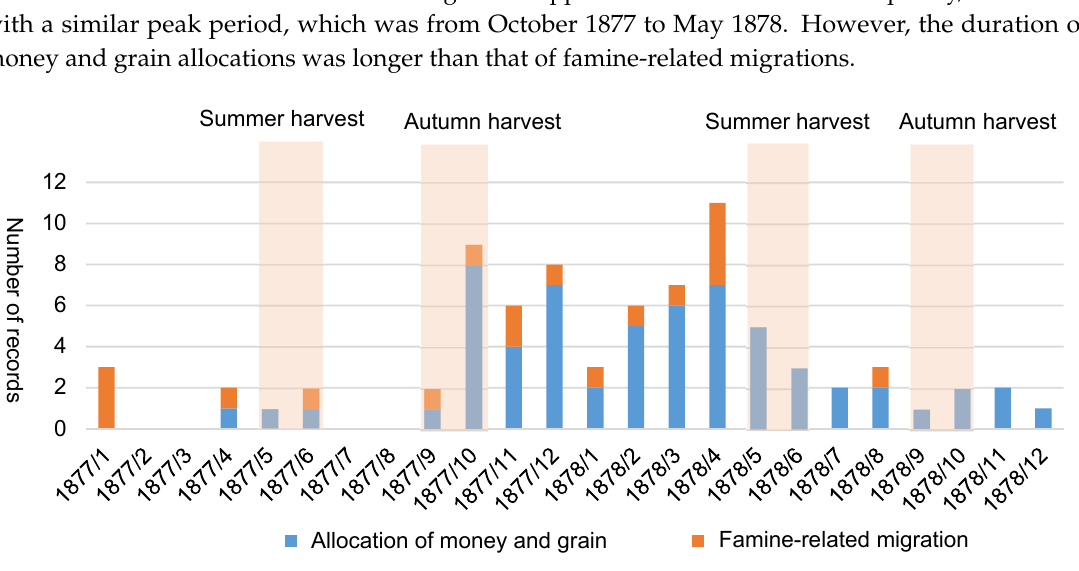
Figure 6. The number of the records of famine-related migrations and relief allocations in 1877–1878.